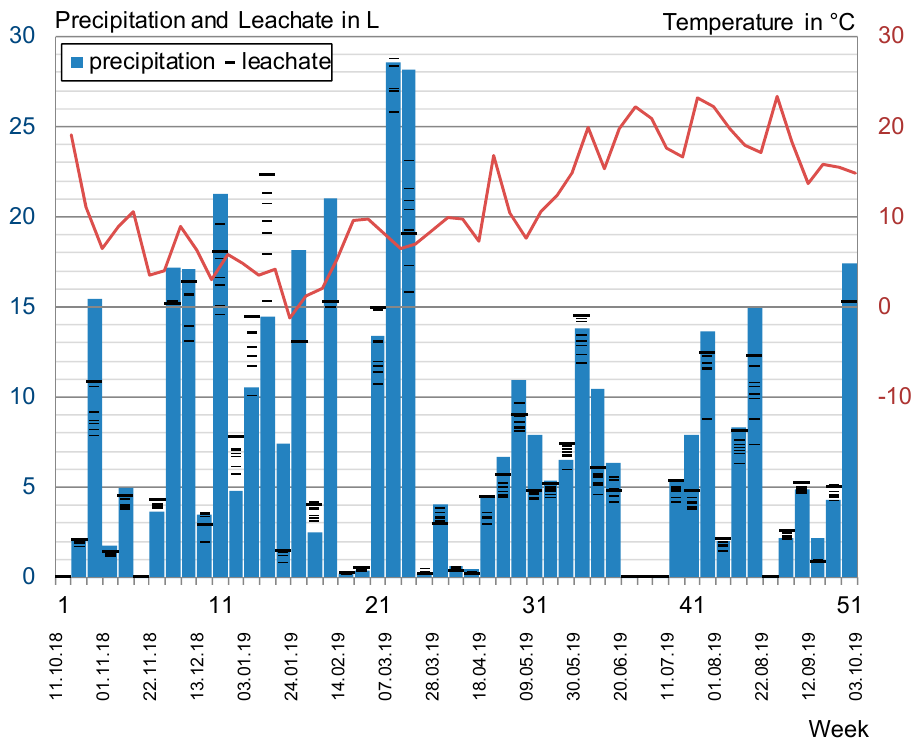
Figure 12. Average temperature, weekly precipitation and collected leachate in L per test specimen.